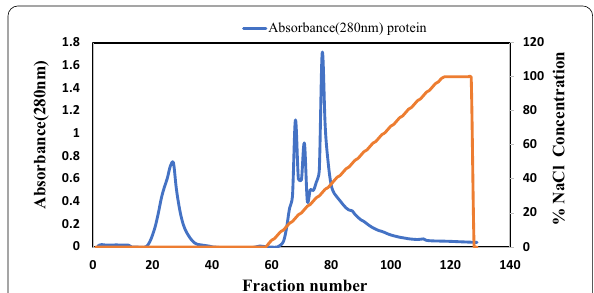
Fig. 3 The protein elution profile during Ion exchange chromatography using MonoQ 5/50 GL column